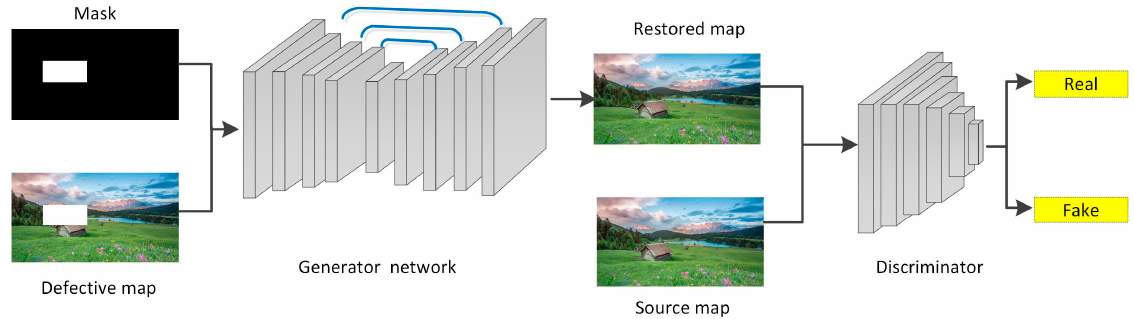
Figure 1. Overall diagram for image inpainting.